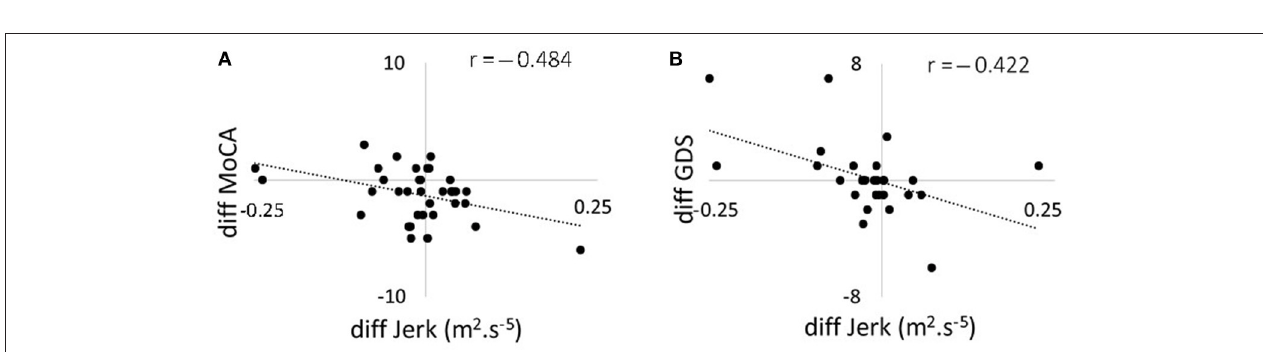
FIGURE 2 | Scatter plots showing the correlation at 36 months between postural parameters and cognitive measures for 120s phase. (A) Mean root mean square against ABC. (B) Mean jerk against MoCA. (C) Mean ellipsis against GDS. ABC, Activities Balance Self Confidence; MoCA, Montreal Cognitive Assessment; GDS, Geriatric Depression Scale.